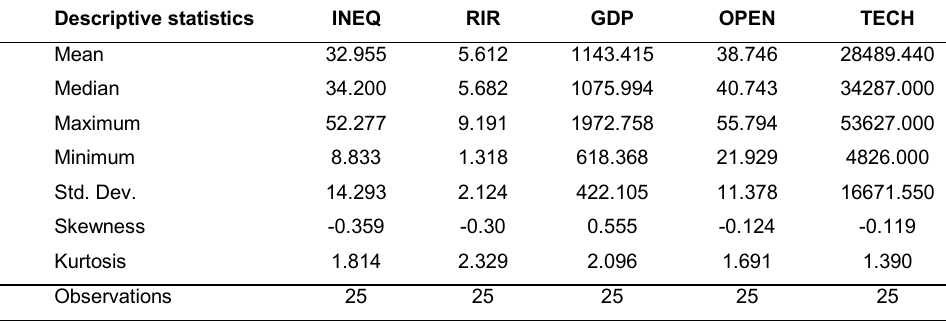
Table 2. Descriptive statistics.